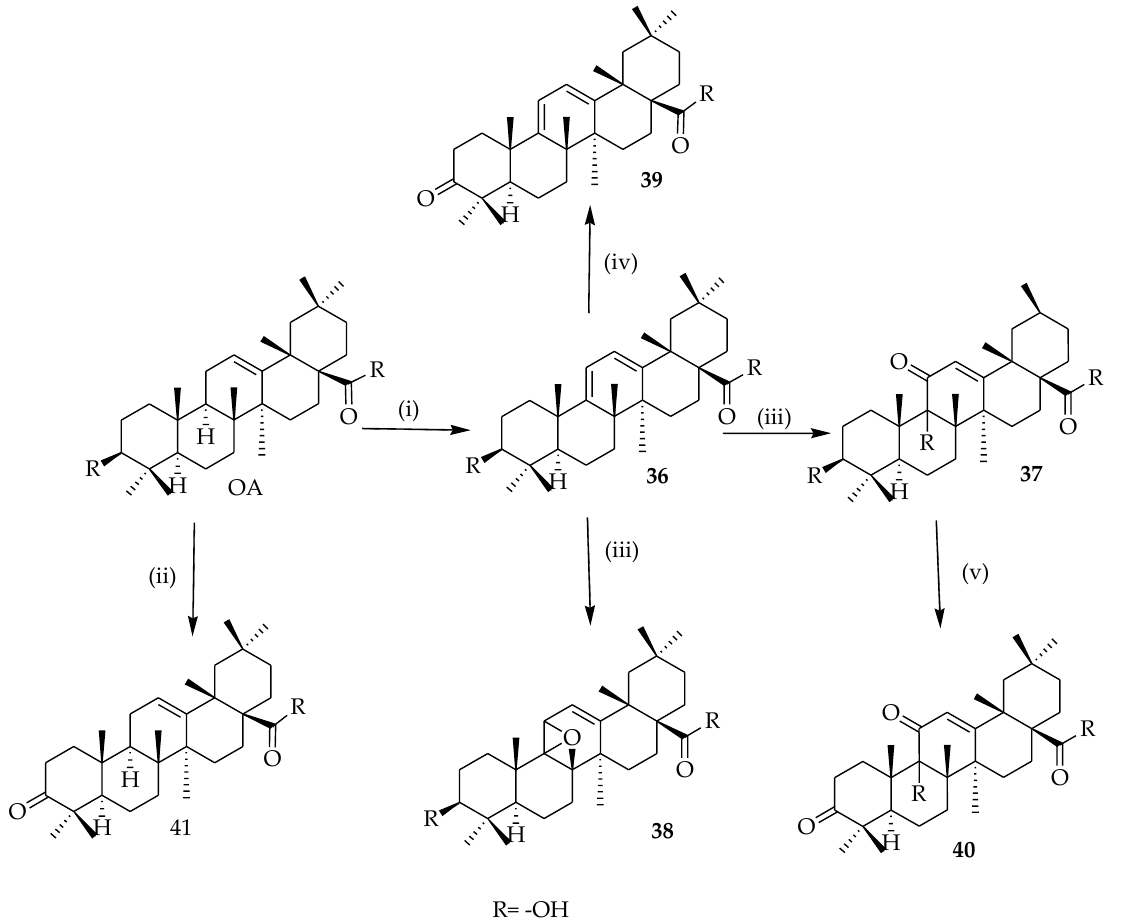
Figure 11. Synthesis route to derivatives. Reagents and conditions: (i) N -Bromosuccinimide (NBS), CCl 4 , light, reflux, 4 h; (ii) chromic acid solution, acetone, 0 °C, 1 h; (iii) Eosin Y,